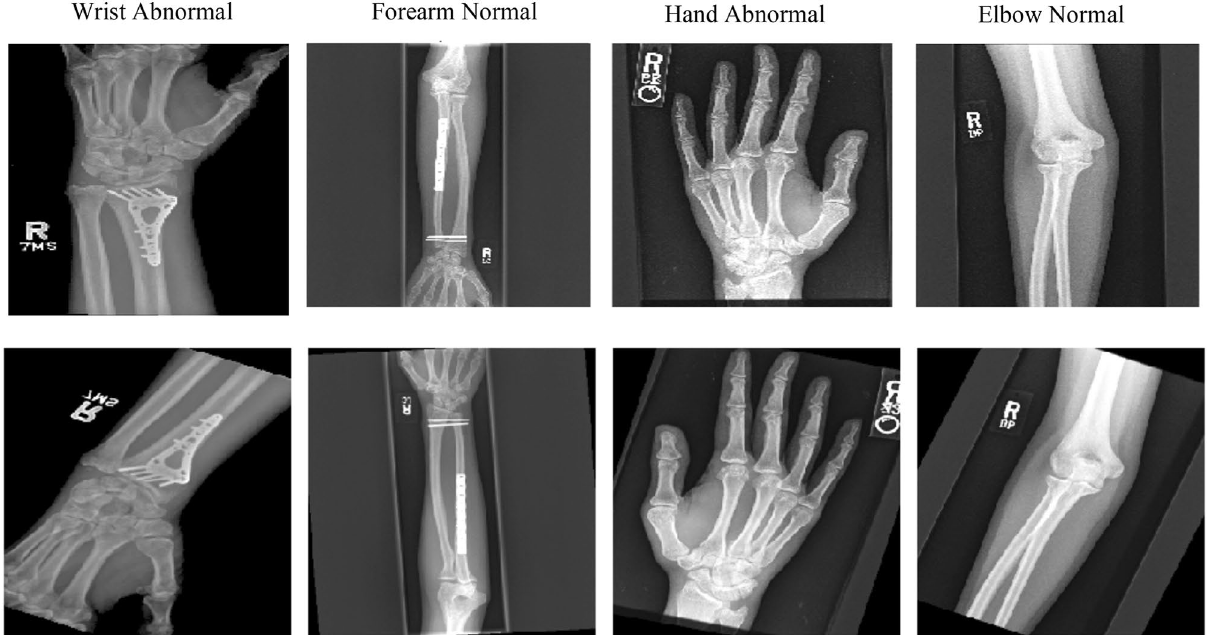
Figure 1. Samples training images. The first row are original images from the MURA dataset. The second row presents images augmented in three sequential operations: a random horizontal flip, a random vertical flip, and ◦ ◦ a random rotation within − 30 to 30